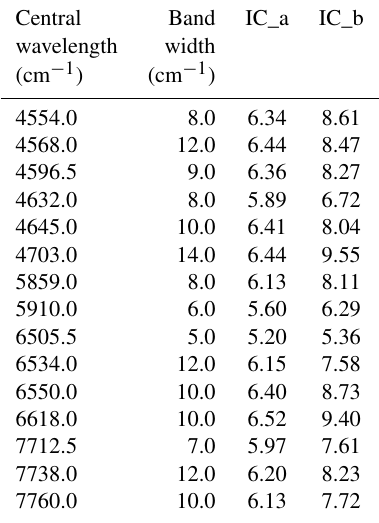
Table 1. Central wavelengths and band widths of the 15 H 2 O ab- sorption bands and the corresponding information contents for re- trievals of only H 2 O SCD (IC_a) and for simultaneous retrievals of H 2 O SCD and AOD